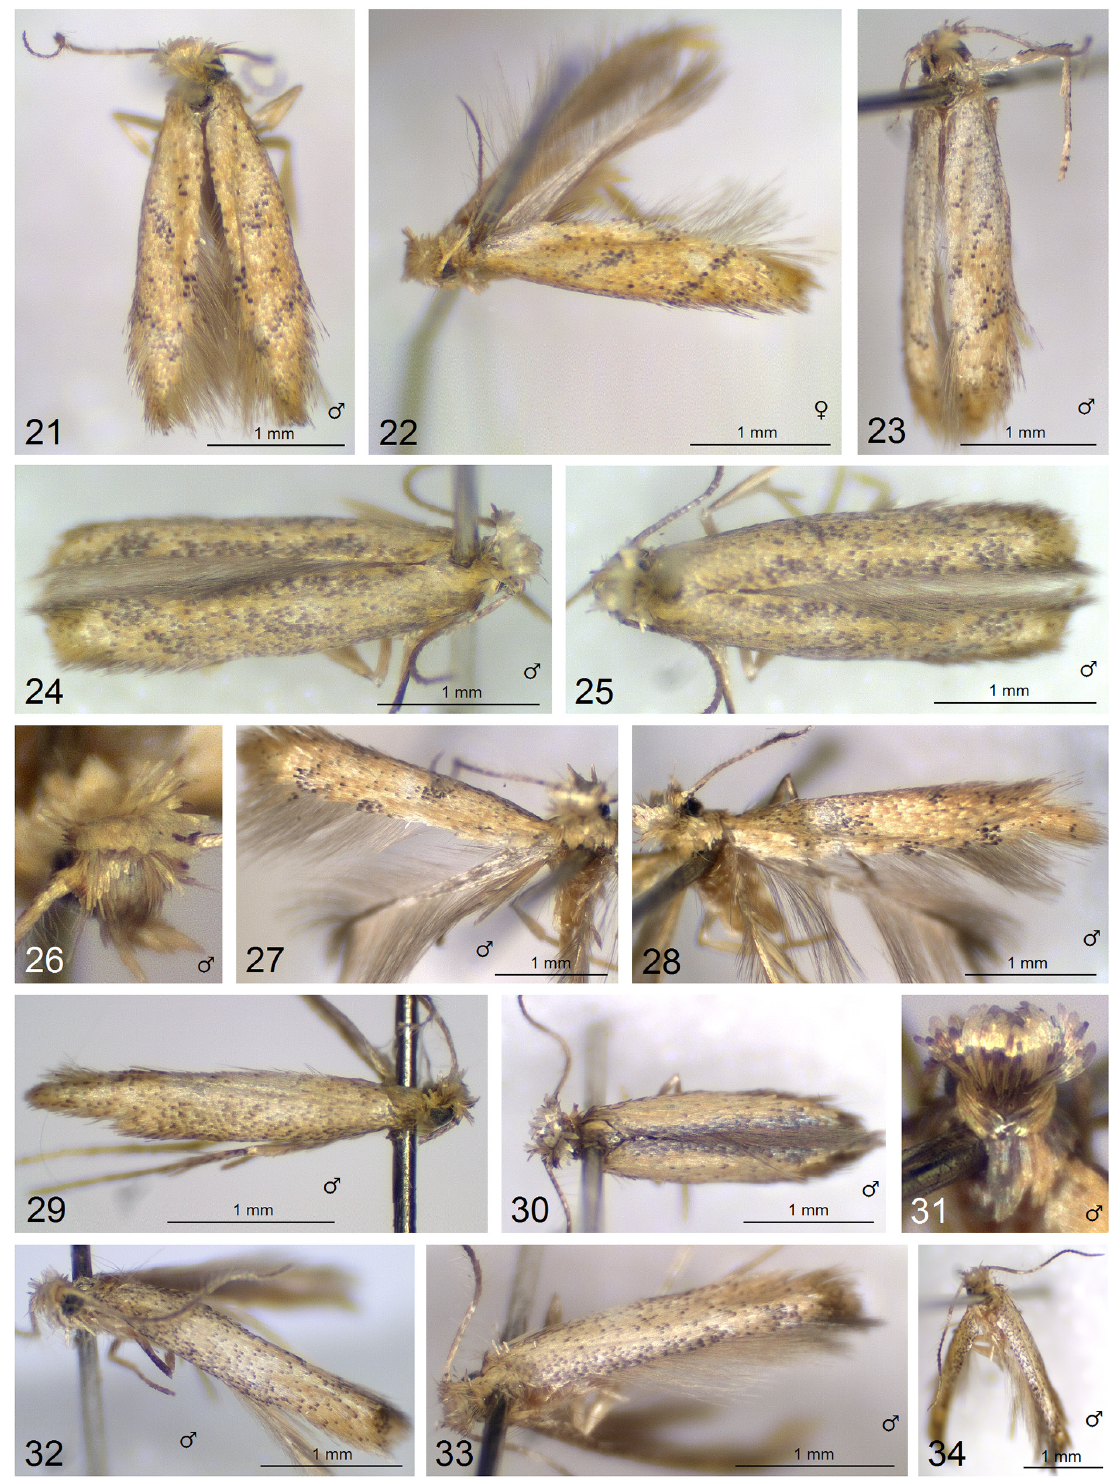
Figs 21–34. Tischeriidae collected in Las Cuevas, Belize. 21 . Paratischeria tubifex sp. nov., holotype (NHMUK 010289272). 22 . Same, paratype (010289282). 23 . Same, paratype (010289276). 24–25 . P. belizensis sp. nov., holotype (010289283). 26–28 . P. neotropicana (010289285). 29 . Dishkeya gouaniae , paratype (010289320). 30 . Coptotriche pulverea (010289324). 31 . Same (010289322). 32–34 . C. forsteroniae , paratype